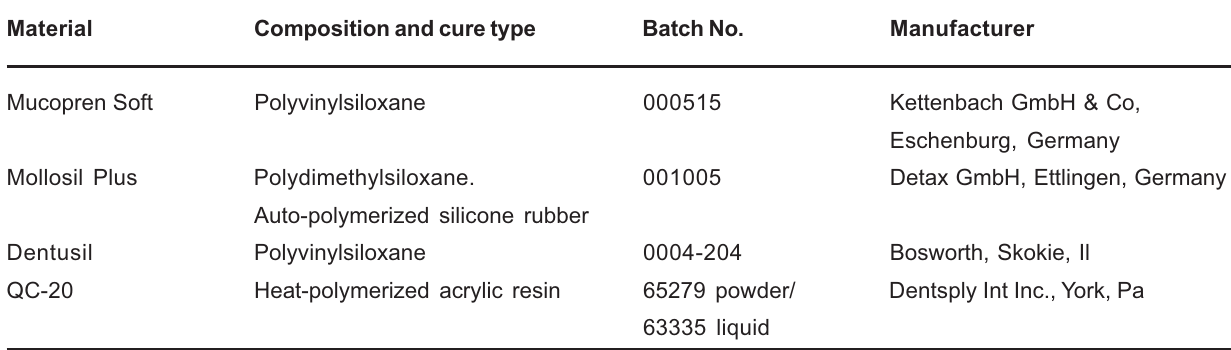
TABLE 1- Silicone-based resilient liners and denture base resin tested in this